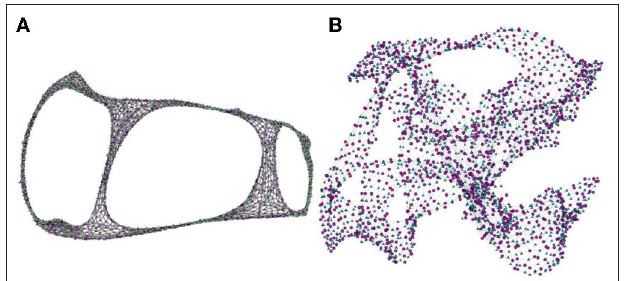
FIGURE 4 | Bipartite network “HB/jagmesh7,” with | V 1 | = 1,138 and | V 2 | = 1,138 nodes, 7,450 links and three holes: (A) a high-resolution rendering the network (from https://sparse.tamu.edu/HB/jagmesh7); (B) a rendering of the full network obtained in the BiNetViz system using the Fruchterman-Reingold layout algorithm, where the holes are not clearly